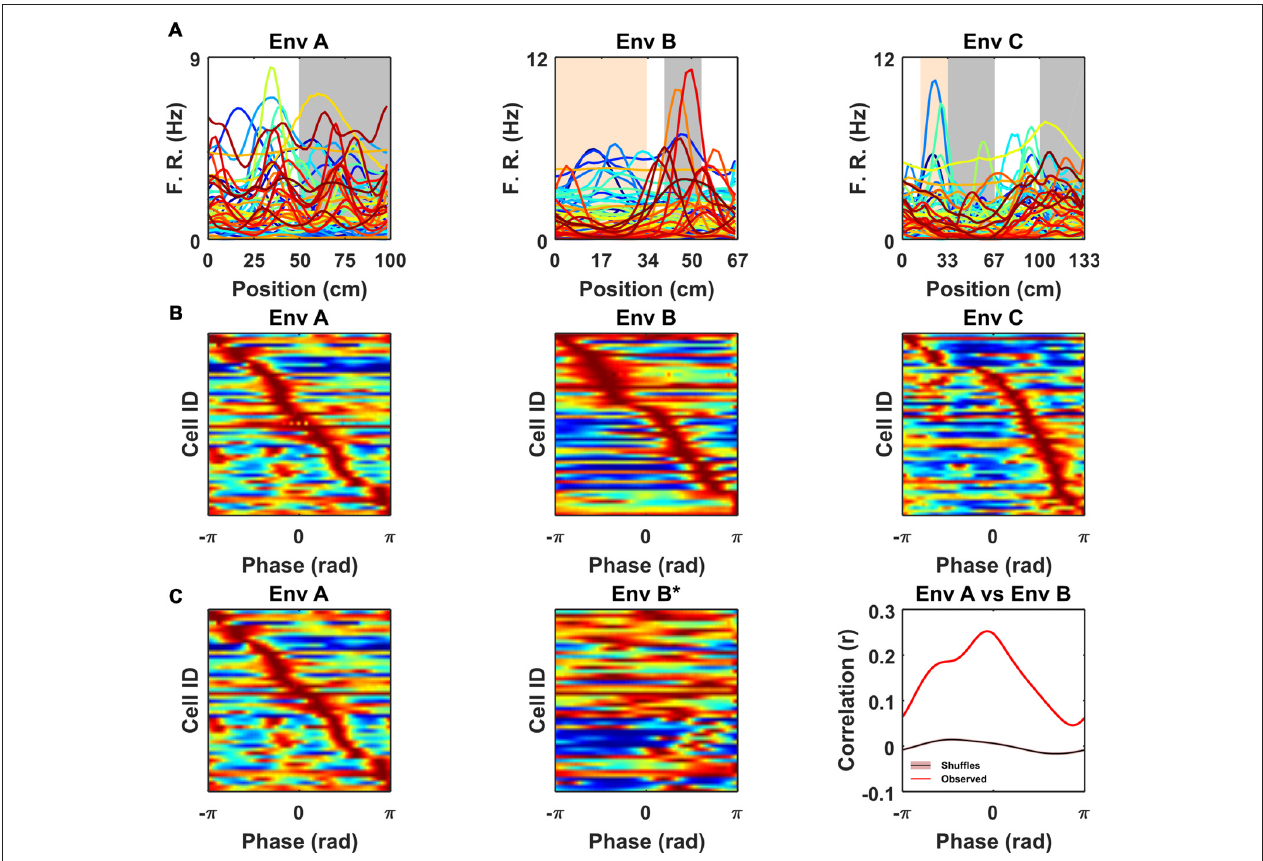
FIGURE 4 | Non-grid periodic cells were strongly modulated by the frequency of the repetitive segments in each VR but were not clustered at specific phases within each segment. (A) Rate maps for each color-coded cell across VR environments showing mean firing rate as function of location within the repeating segment. Note the differences in the peak firing rate and location of the spatial tuning curves across cells. (B) Ratemaps of all cue-locked cells sorted according to location of peak firing. For comparison across environments location within each repeated segment has been converted to a phase (radians). Note the sequence of firing within each environment with no strong preference for any particular phase. (C) Ratemaps from environments A ( Left ) and B ∗ ( Middle ) sorted according to the order of their peaks in A. ( Right ) Cross-correlation between A and B ∗ shows a significant peak (vs. 1,000 shuffles, purple line also indicates shuffle confidence interval), suggesting a tendency for the relative phase of ratemaps to be preserved between environment A and